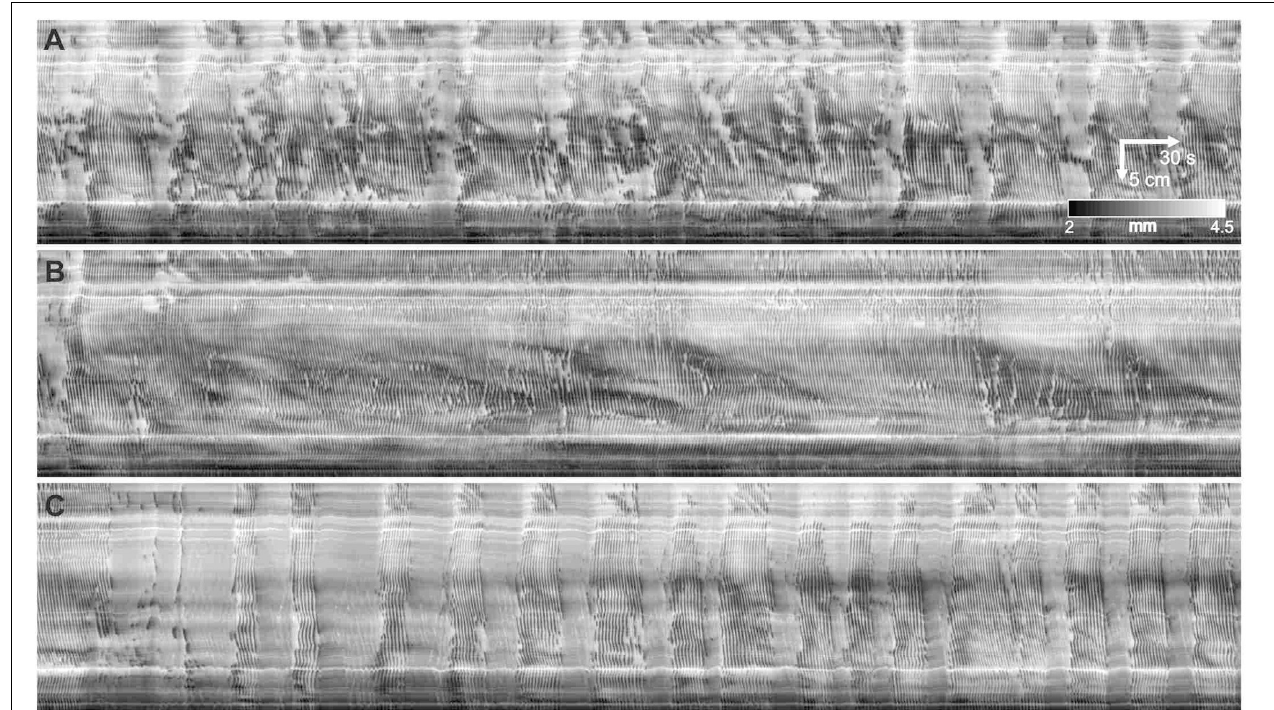
FIGURE 5 | Modulation of clusters by nitric oxide. (A–C) Three 10 min sequential sections of a 30-minute DMap. 25 µ M N-omega-nitro-L-arginine added at start of panel (B) . 1 µ M sodium nitroprusside added at start of panel (C) . It appears that the physiological provision of a continuing level of nitric oxide is much noisier compared to the constant level of nitric oxide by SNP, that always gives a highly regular cluster